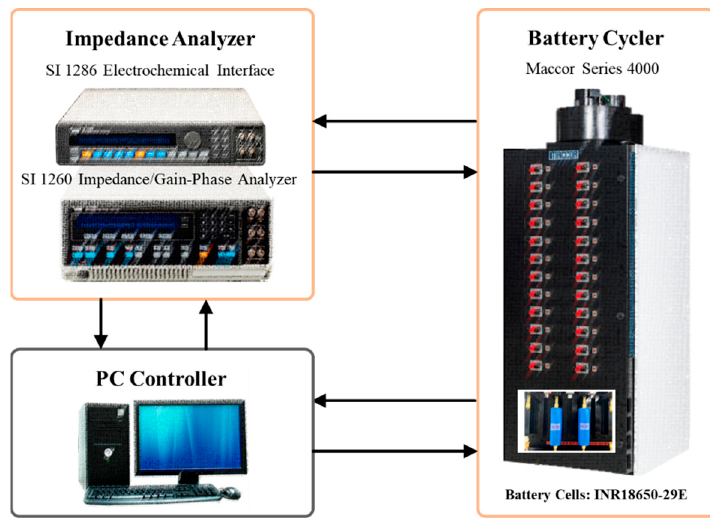
Figure 1. Experimental setup.